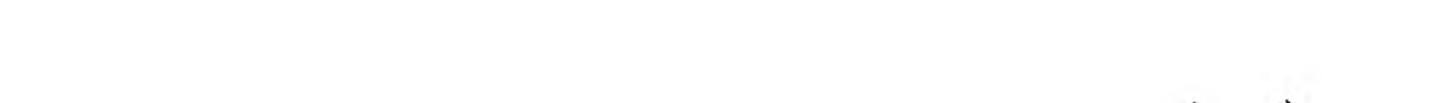
Process facilitated